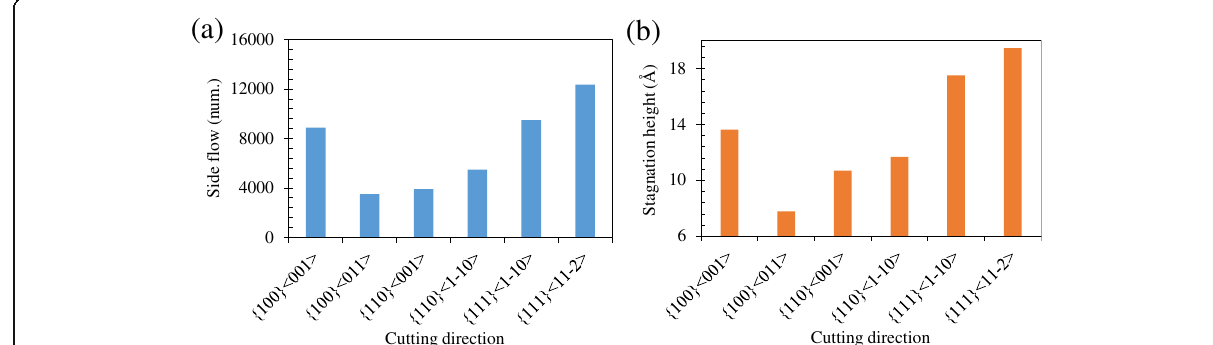
Fig. 6 a Number of atoms flow to the side of tool edge and b stagnation height at the side of tool edge at different cutting directions